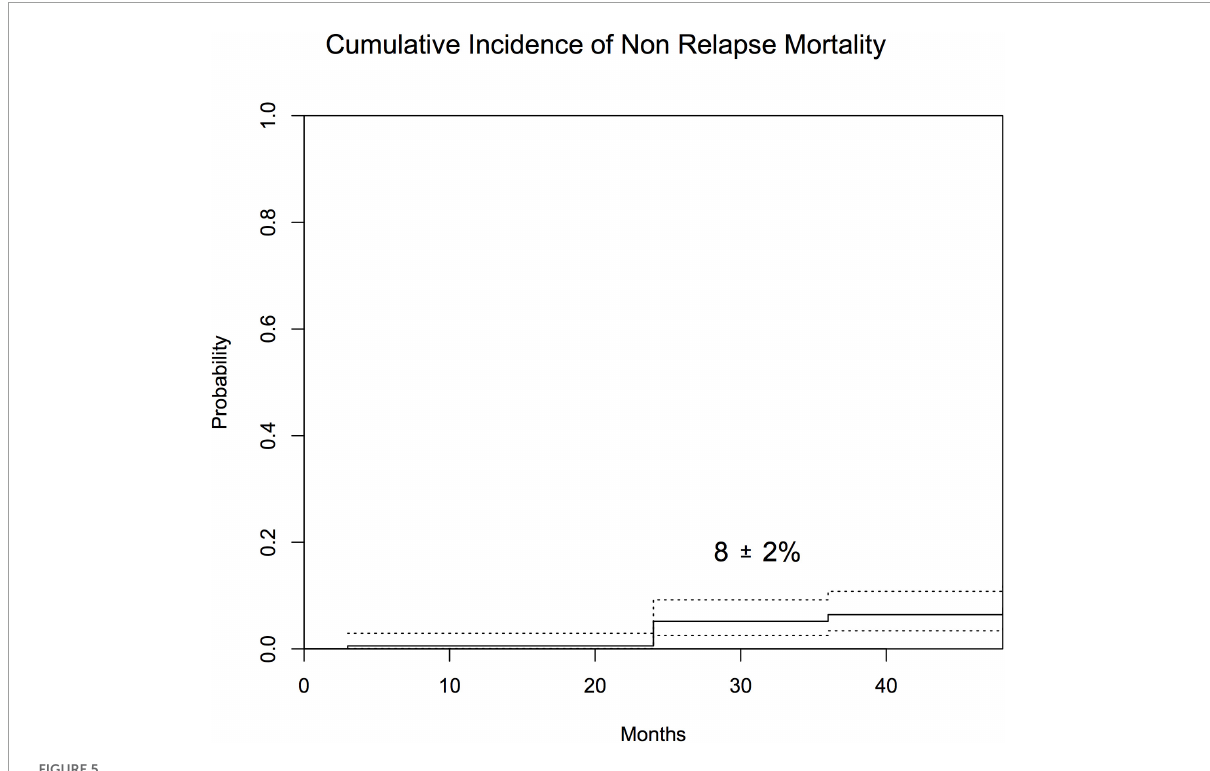
FIGURE5 Cumulative incidence of NRM after 1 year